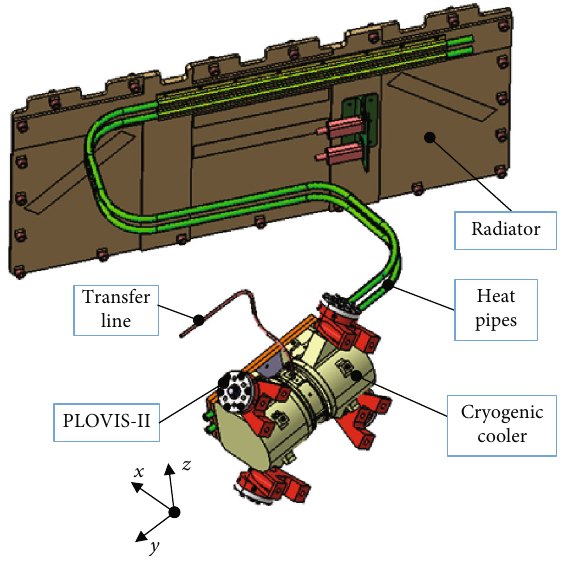
Figure 3: Thermal design con fi guration of cooler assembly with PLOVIS-II.